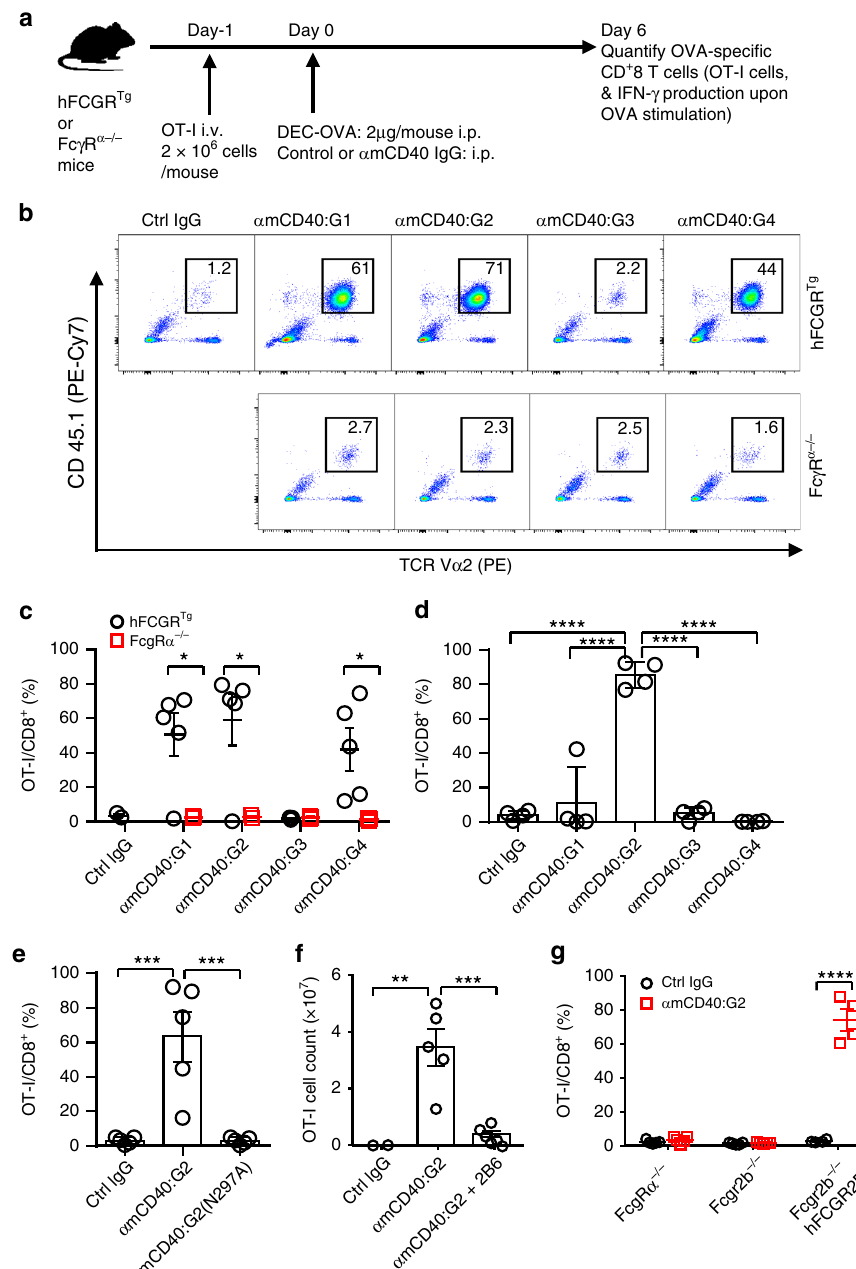
Fig. 1 Divergent hIgG agonism and speci fi c Fc γ R-binding requirement. a Diagram showing the OVA-speci fi c CD8 + T-cell response model. In brief, Fc γ R- humanized (hFCGR Tg ) or -de fi cient (Fc γ R α − / − ) mice were adoptively transferred with OT-I cells on day-1, immunized intraperitoneally (i.p.) with 2 μ g of DEC-OVA in the presence of control or anti-CD40 antibodies on day 0. Splenocytes were harvested to quantify OVA-speci fi c CD8 + T cells on day 6. b , c Representative FACS pro fi le ( b ) and quanti fi cation ( c ) showing the percentage of OT-I cells (CD45.1 + TCRV α 2 + ) among CD8 + T cells in mice treated and analyzed as in ( a ) together with 30 μ g of indicated control or anti-mCD40 antibodies. Numbers of mice: b , c three hFCGR Tg mice for Ctrl IgG, fi ve hFCGR Tg , and three Fc γ R α − / − mice for other groups. d – f Quanti fi cation of OT-I cells as the percentage of OT-I cells among CD8 + T cells ( d , e ) or cell count ( f ) in Fc γ R-humanized mice treated and analyzed as in ( a ) together with 10 μ g ( d , e ) or 30 μ g ( f ) of indicated control or anti-mCD40 antibodies (the N297A mutation abrogates Fc – Fc γ R binding) and with/without Fc γ RIIB-blocking antibody 2B6 (150 μ g per mouse) ( f ). Numbers of mice: d four mice per group; e fi ve mice per group; f two mice for Ctrl IgG, fi ve mice for α mCD40:G2, six mice for α mCD40:G2 + 2B6. g Quanti fi cation of OT-I cells as the percentage of OT-I cells among CD8 + T cells in mice of indicated genotypes (Fc γ R-de fi cient (FcgR α − / − , fi ve mice per group), Fc γ RIIB-de fi cient (Fcgr2b − / − , fi ve mice per group) or humanized (Fcgr2b − / − hFCGR2B Tg , four mice per group)) treated and analyzed as in ( a ) together with 10 μ g of indicated control or IgG2 anti-mCD40 antibodies. Each symbol represents an individual mouse. Bars represent the mean ± SEM. * p ≤ 0.05, ** p ≤ 0.01, *** p ≤ 0.001, **** p ≤ 0.0001; unpaired two-tailed t test ( c , g ), one-way ANOVA with Holm – Sidak ’ s post hoc ( d – f ). Source data ( c – g ) are provided as a Source Data fi le. A representative of two independent experiments is